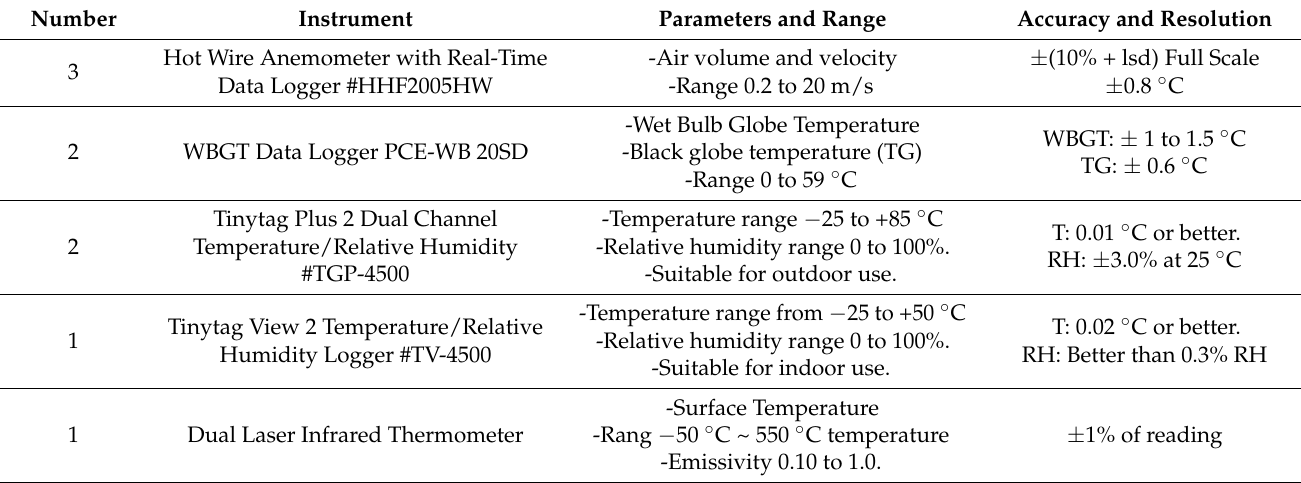
Table 4. The equipment used in the field work. Reproduced from Bagasi and Calautit [3].